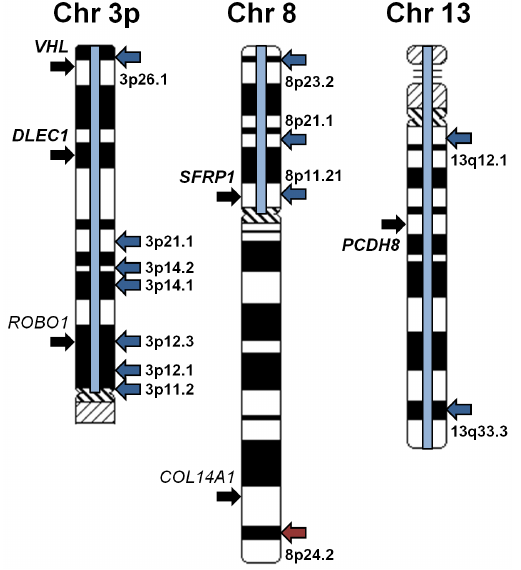
Figure 2. TCGA KIRC hypermethylated genes that occur in regions of common whole/partial chromosomal or focal loss/ deletion. The regions of chromosomal variation identified from the published TCGA Kidney Renal Clear Cell Carcinoma (KIRC) project data for chromosomes 3p, 8 and 13 were mapped with the regions of whole/ partial chromosomal loss/deletion highlighted with blue bars and regions of focal loss or gain designated with blue or red arrows respectively. Genes that demonstrated tumor-specific hypermethylation in either cohort were designated with black arrows and those genes that were present in both cohorts were highlighted in